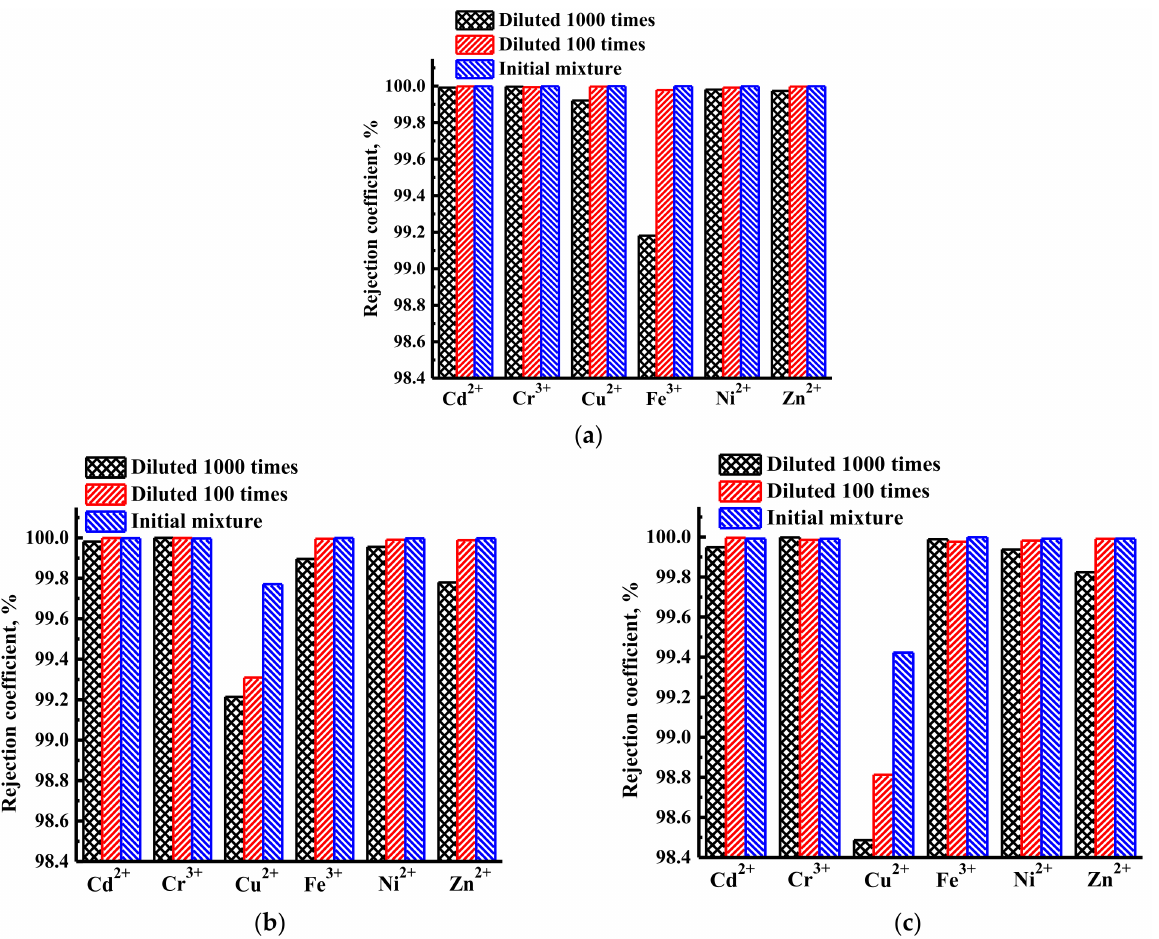
Figure 7. Rejection coefficients of heavy metal ions for ( a ) PIM-1, ( b ) PIM-1/MIL-125, and ( c ) PIM- 1/MIL-140A membranes during the nanofiltration at 50 atm: a sample of untreated wastewater (initial mixture), a sample of untreated wastewater, diluted 100 times, and a sample of untreated wastewater diluted 1000